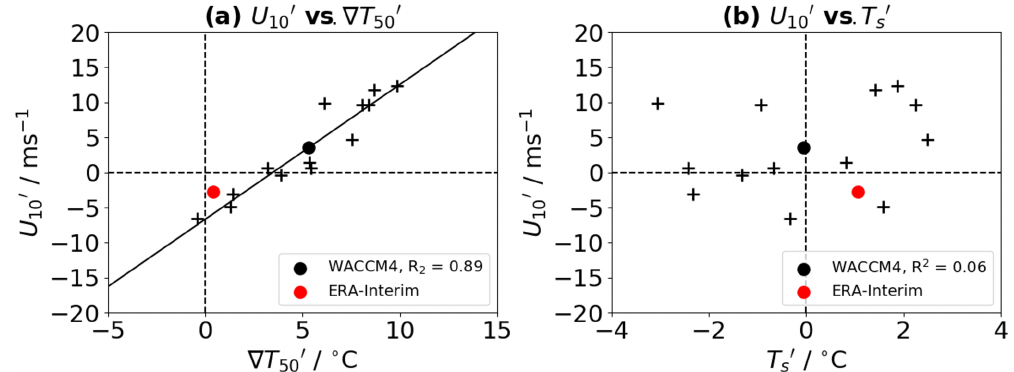
Figure 5. Scatter plots showing the relationship between U (cid:48) and the anomalies in (a) the NH meridional temperature gradient ∇ T (cid:48) (b) the Eurasian surface air temperature T (cid:48) s ( ◦ C). Crosses show individual ensemble members, and the black dot shows the ensemble mean value. The red dot shows the ERA-Interim